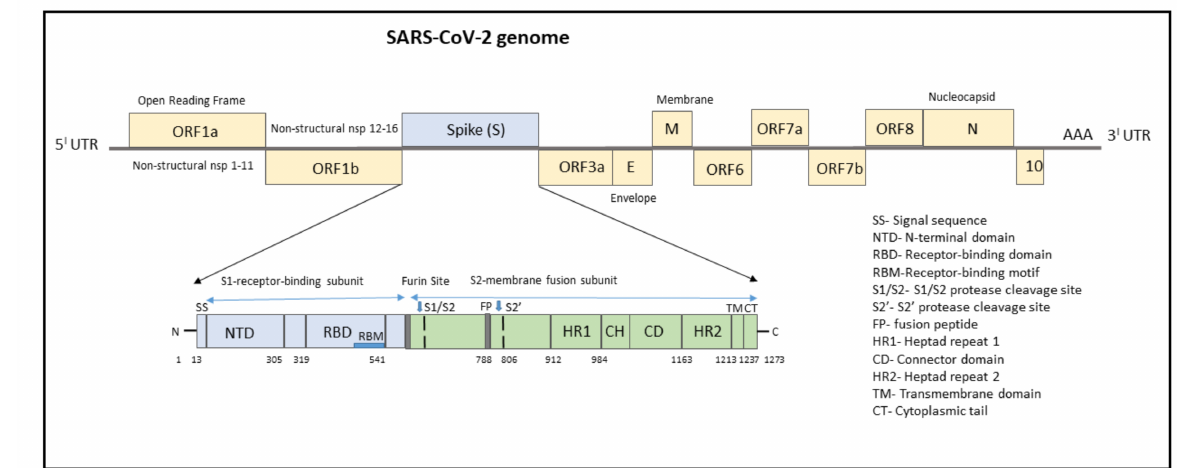
Figure 1. Structure of SARS-CoV-2 genome with domain structure of the Spike